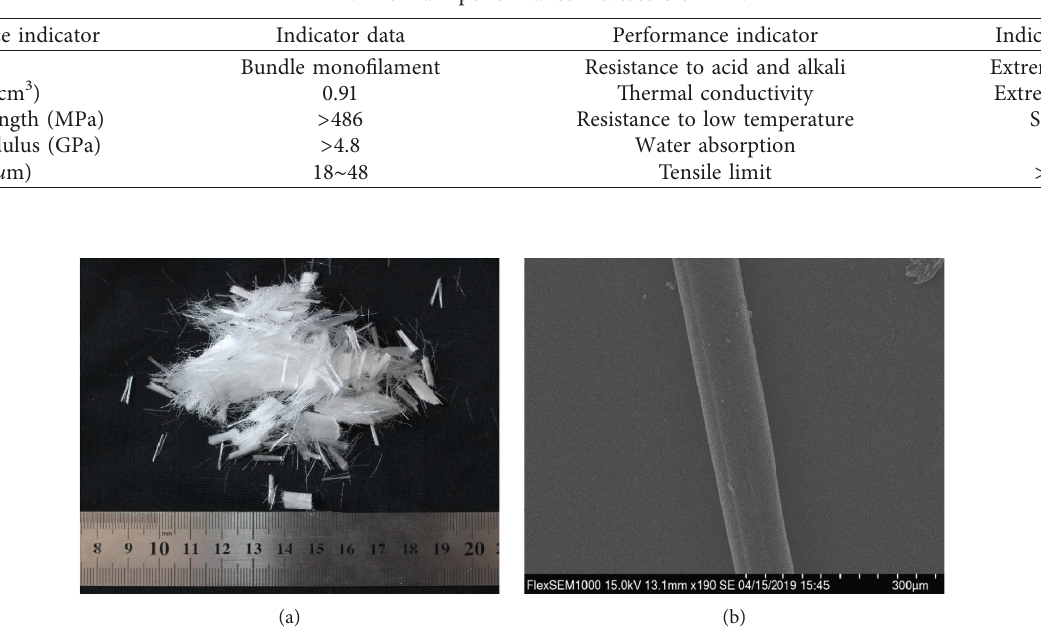
Table 2: The main performance indicators of PPF.